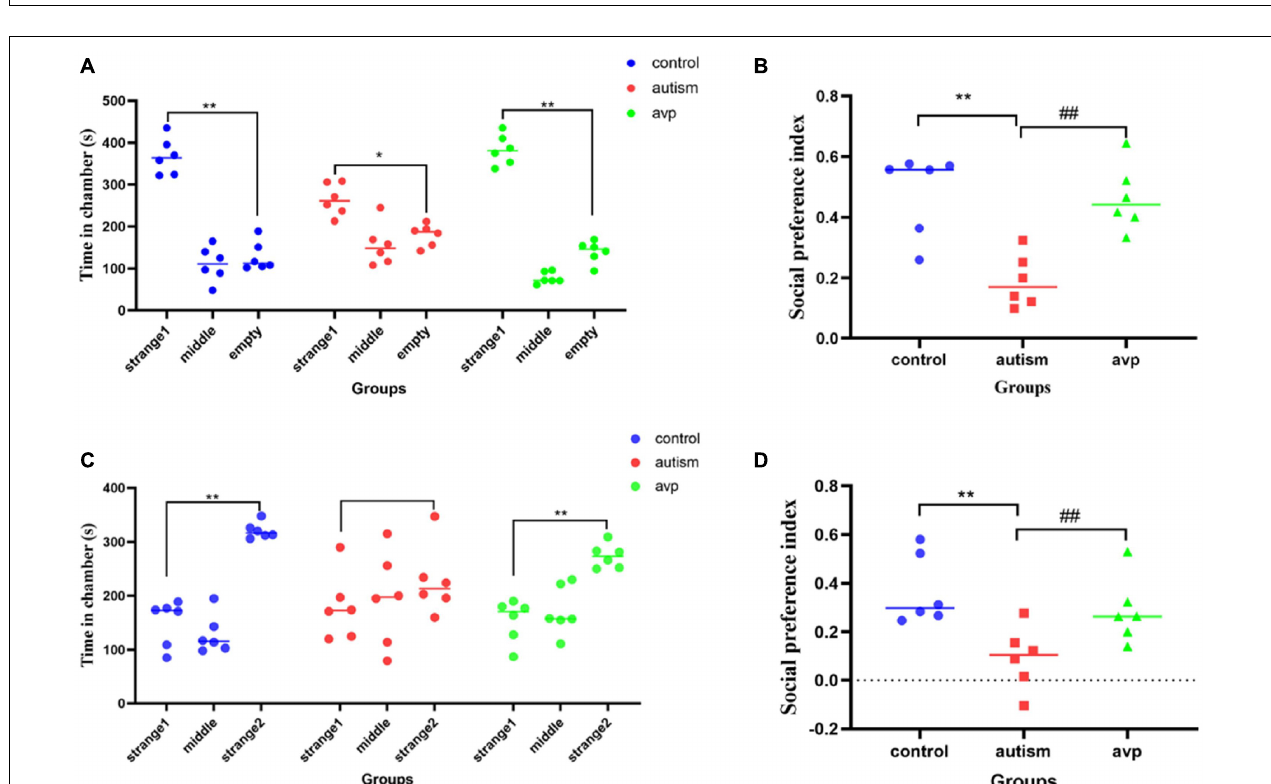
FIGURE 5 | The results of three-chamber test in each group ( n = 6 in each group). (A) The results of social preference test in each group. Comparison of the time spent in the side with stranger 1 vs. the side with empty: * p < 0.05, ** p < 0.01. (B) Social preference index in social preference test. Compared with the control group: ** p < 0.01; compared with the autism group: ## p < 0.01. (C) The results of social novelty test in each group. Comparison of the time spent in the side with stranger 1 vs. the side with stranger 2: * p < 0.05, ** p < 0.01. (D) Social preference index in social novelty test. Compared with the control group: ** p < 0.01; compared with the autism group: ## p <